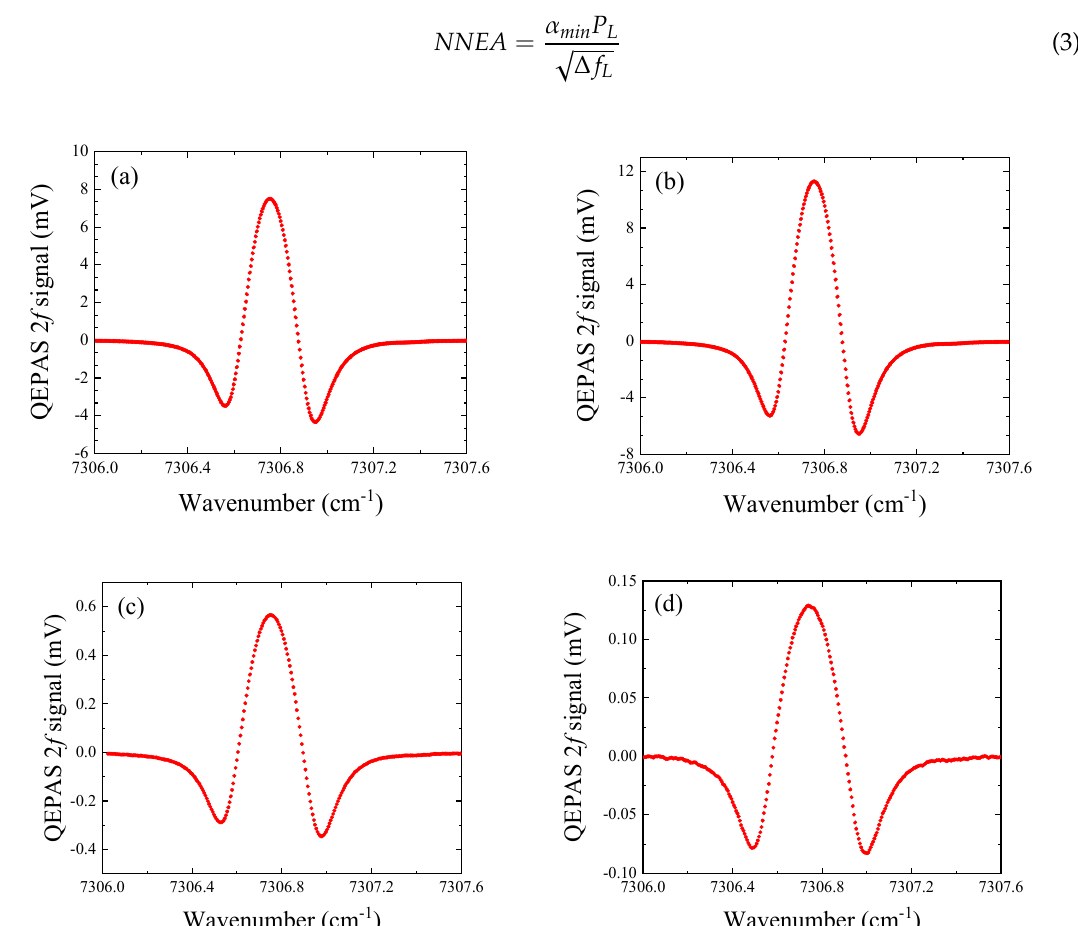
Figure 6. Optimized 2 f QEPAS signals. ( a – d ) QTF#1, #2, #3, and #4, respectively. The laser wavelength was targeted at the 7306.75 cm − 1 H 2 O absorption line.